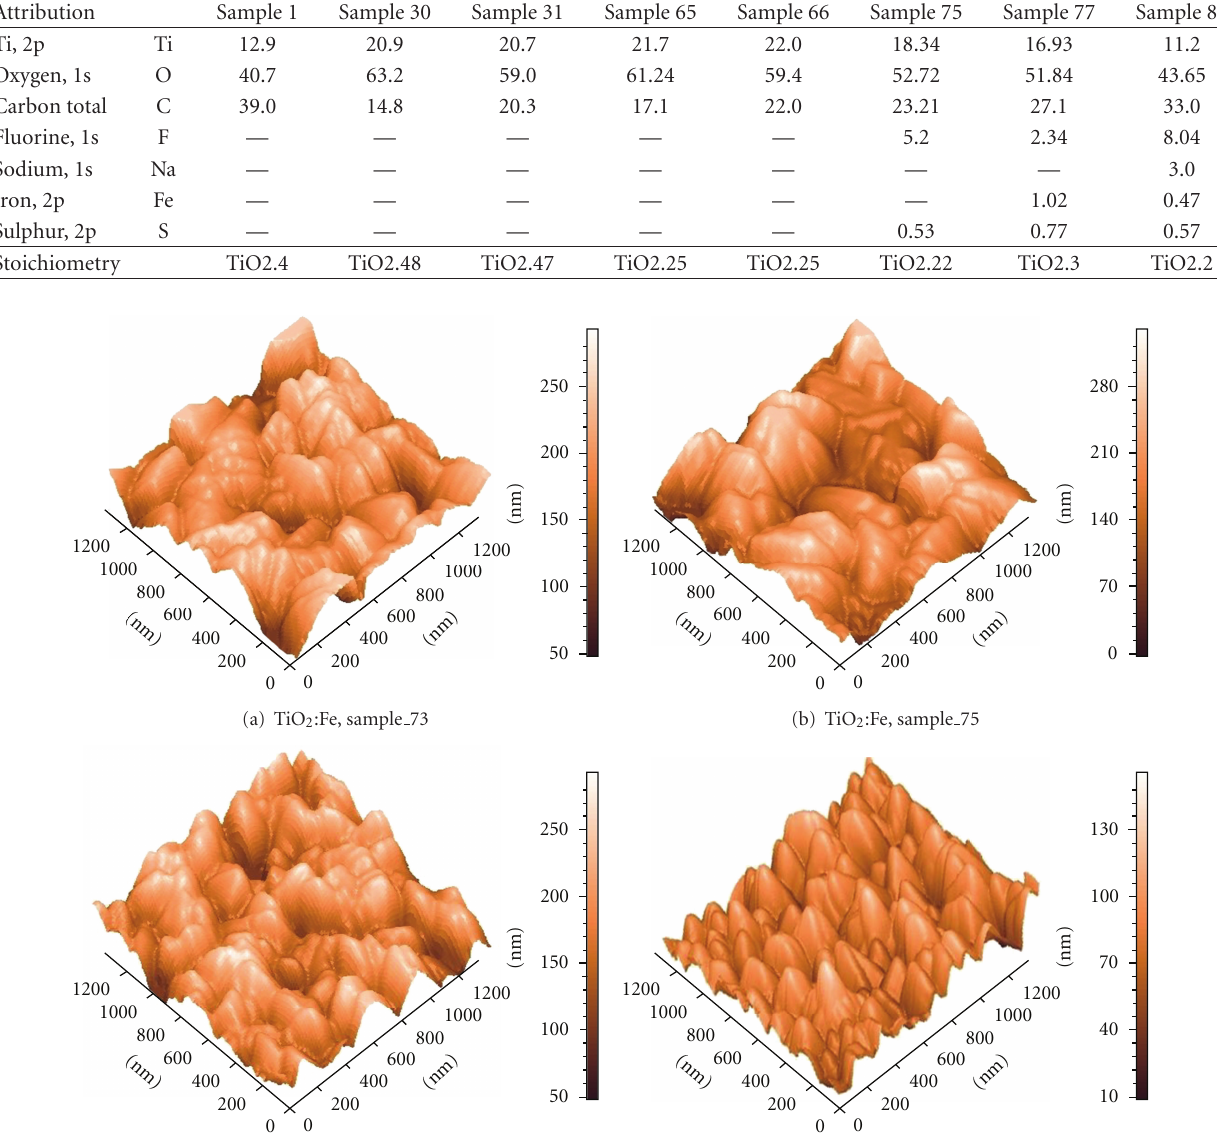
Table 4: Composition (atom percentage, %) of TiO 2 films according to XPS analyses (The composition is shown for XPS spectra taken at 0 ◦ ).